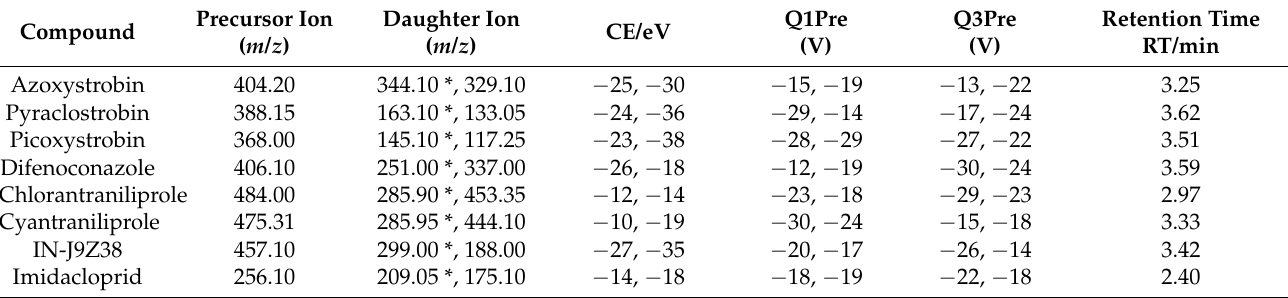
Table 1. Mass parameters of eight targeted